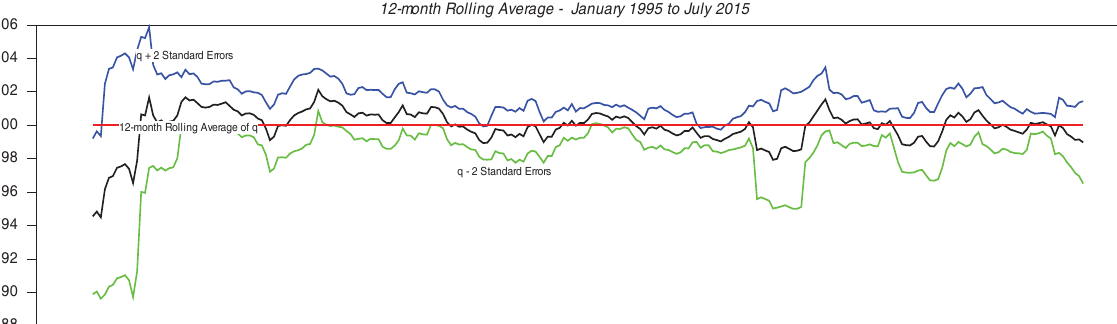
Fig. 14. Mexican peso-Chinese yuan real exchange rate